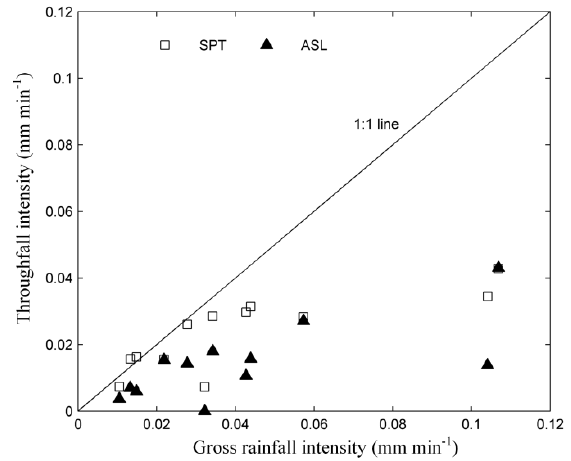
Figure 3. Rainfall intensity reduction of the plant canopy.